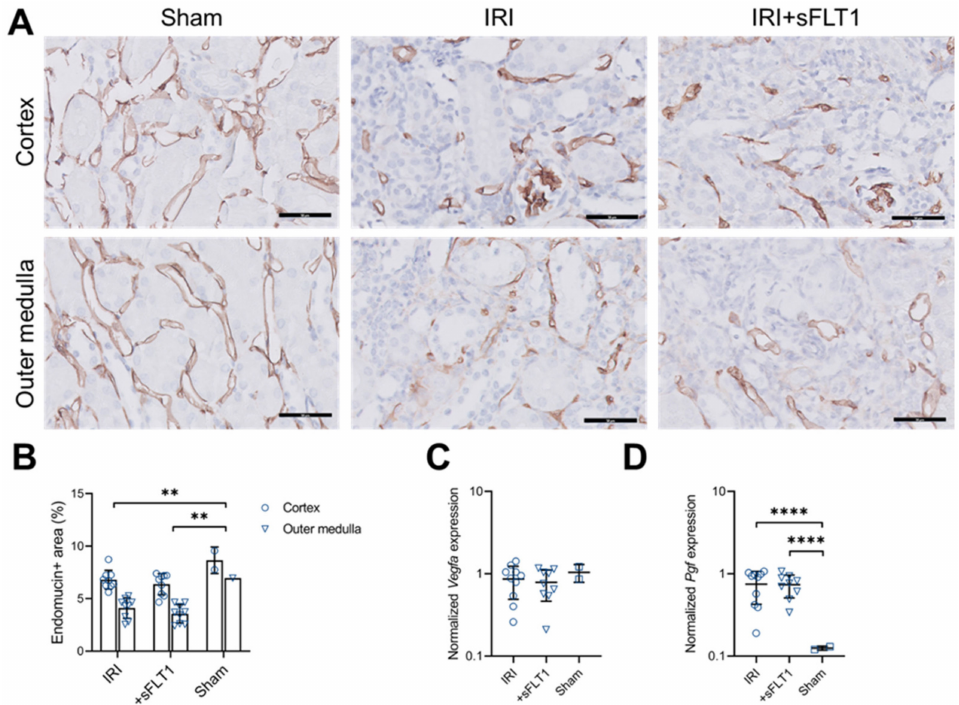
Figure 3. sFLT1 has no effect on chronic endothelial injury after IRI. ( A , B ) Kidney sections were immunostained with anti-endomucin as shown in ( A ) and positively stained areas were quantified in cortex and outer medulla ( B ). Scale bars, 50 µ m. Linear mixed model. Quantitative PCR for ( C ) Vegfa and ( D ) Pgf was performed on whole-kidney mRNA. One-way ANOVA, **** p < 0.001, ** p <